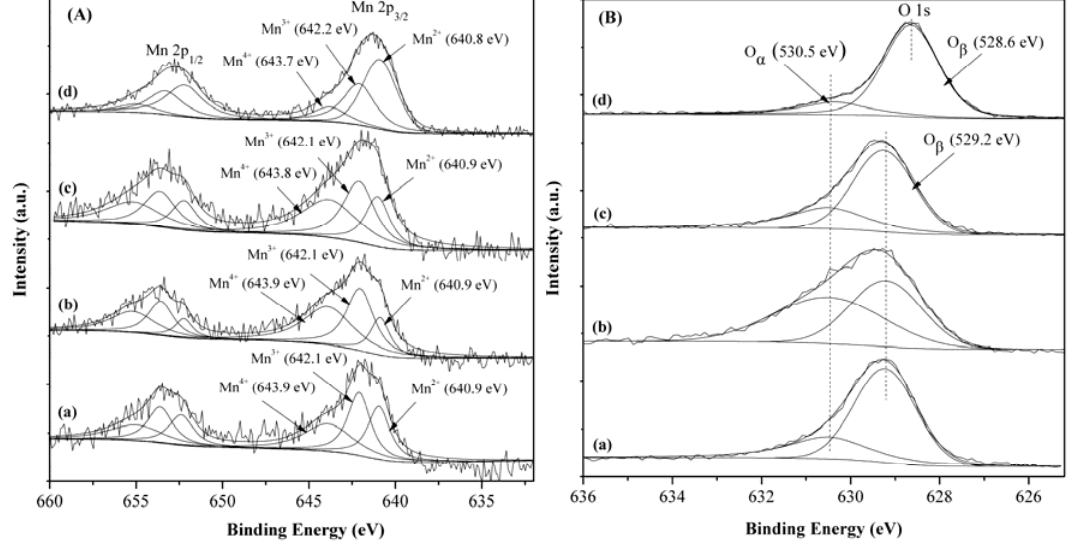
Figure 6. XPS spectra for ( A ) Mn 2p and ( B ) O 1s of the catalysts: ( a ) 10Mn/TiO 2 (773 K); ( b ) 10Mn ‐ 5Co/TiO 2 (673 K); ( c ) 10Mn ‐ 5Co/TiO 2 (773 K); and ( d ) 10Mn ‐ 5Co/TiO 2 (973 K). ( b ) 10Mn-5Co/TiO 2 (673 K); ( c ) 10Mn-5Co/TiO 2 (773 K); and ( d ) 10Mn-5Co/TiO 2 (973